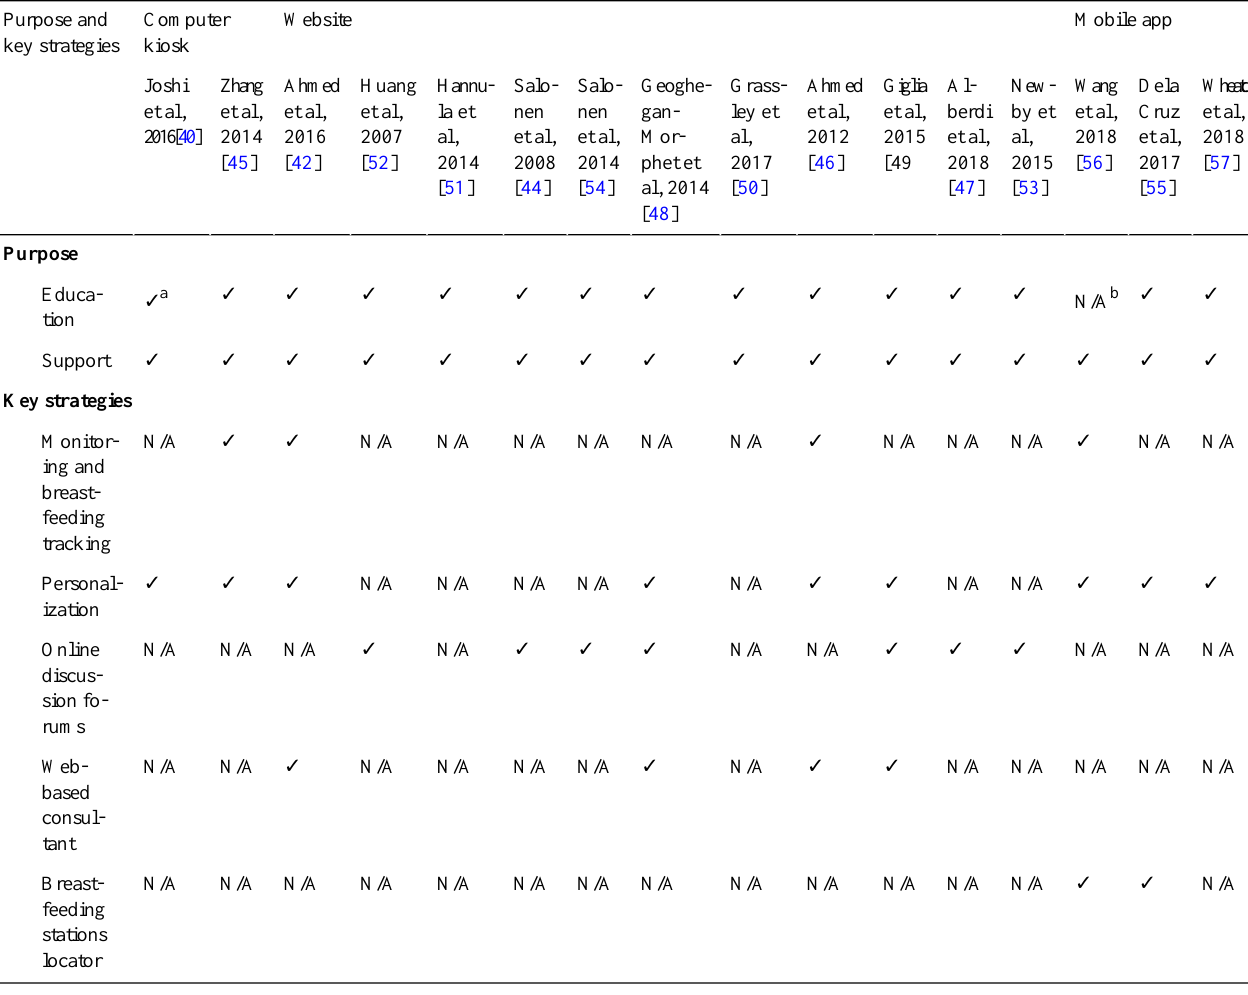
Mobile appWebsiteComputer kioskPurpose and